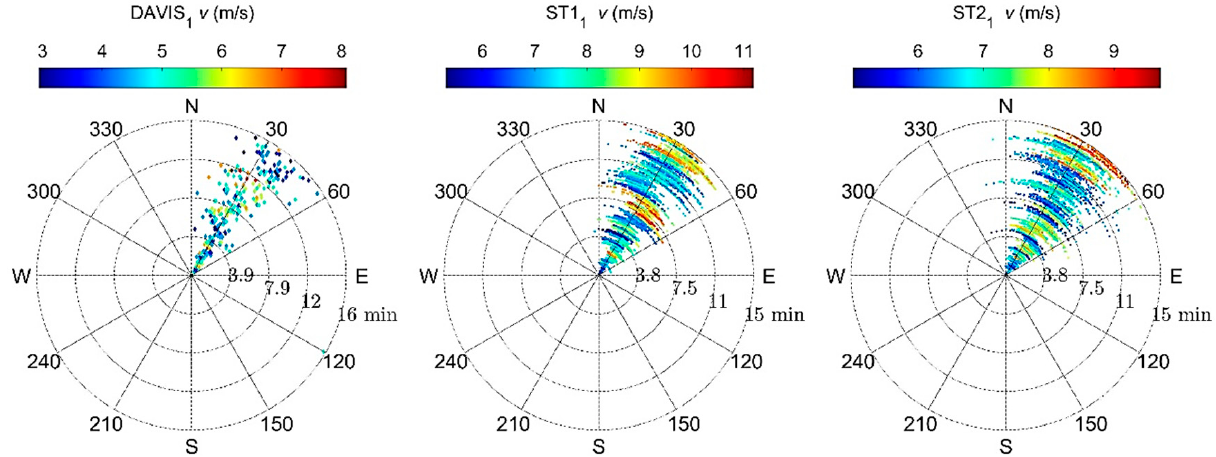
Figure 11. Wind speed and direction values, gathered by Davis ( left ), ST_1 ( middle ) and ST_3 ( right ) during the considered 15 min measuring interval.